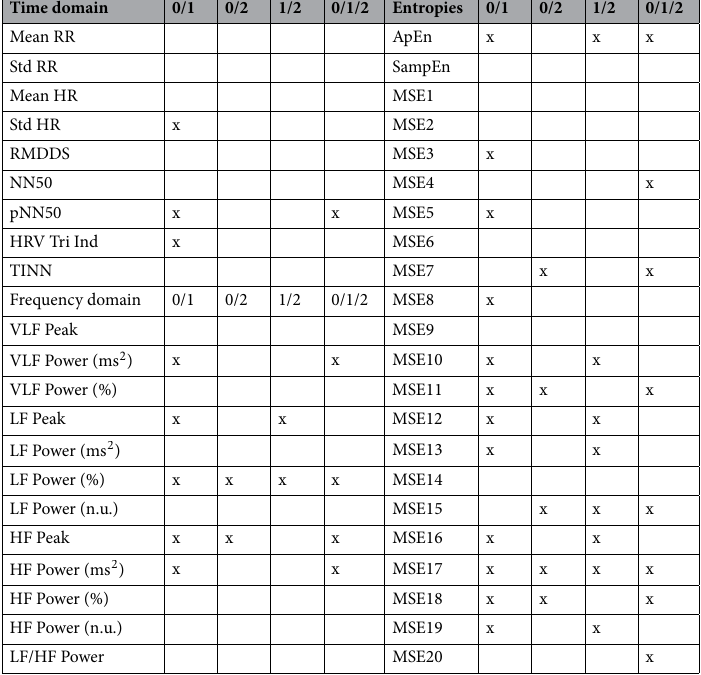
Table 1. Features retained from the LASSO technique for each group comparison.